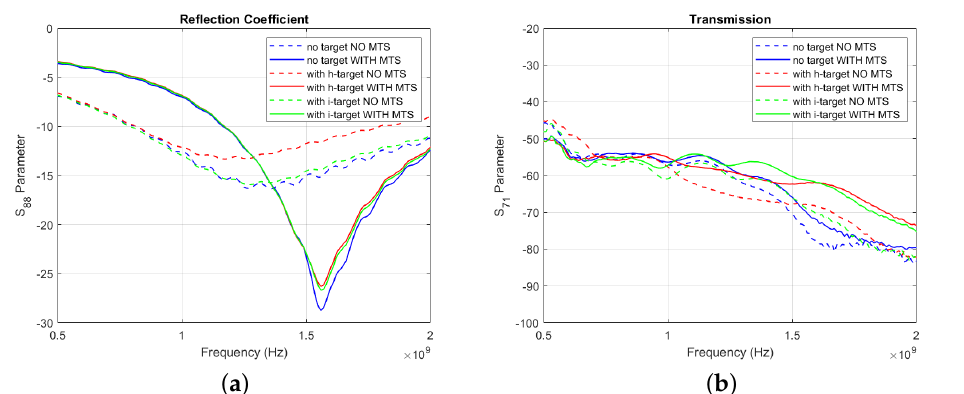
Figure 9. ( a ) Measured S 88 Parameter for the spear patch antenna array in the “with target” (red lines) and “no target” (blue lines) configuration, with (solid lines) and without MTS (dashed lines) ( b ) Measured S 71 Parameter for the spear patch antenna array in the “with target” (red lines) and “no target” (blue lines) configuration, with (solid lines) and without MTS (dashed